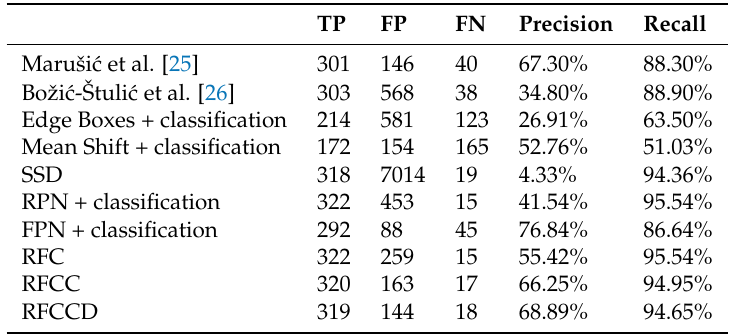
Table 1. Detection results obtained with several methods. The first column contains the names of methods. The second column shows a number of True Positive detections (TP), followed by False Positive detections (FP) and False Negative detections (FN). The last two columns show the standard precision and recall measures calculated as follows: Precision = RPN, Region Proposal Network; FPN, Feature Pyramid Network; RFC, RPN + FPN+ Classification; RFCC, RFC + Context; RFCCD, RFCC + Deviation.